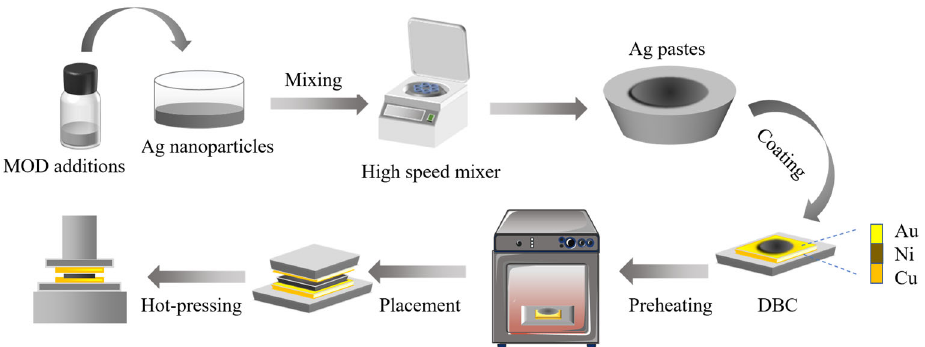
Figure 2. Preparation process of Ag pastes and sintered joints.